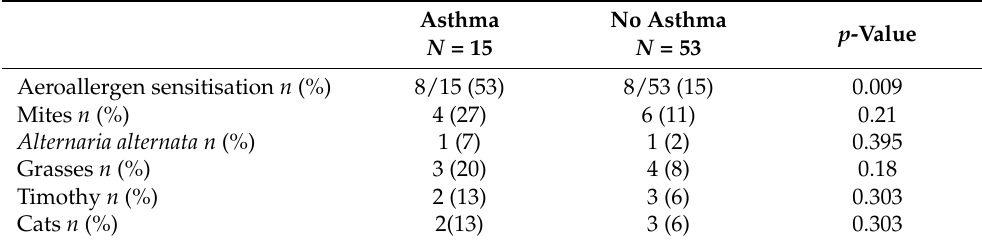
Table 2. Aeroallergen sensitisation profiles.